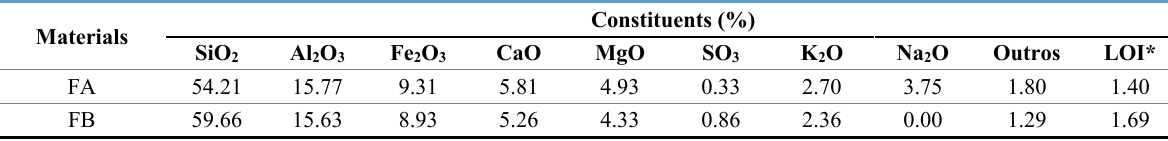
Table 4. Chemical composition, in oxides, of the granitic rock fines studied